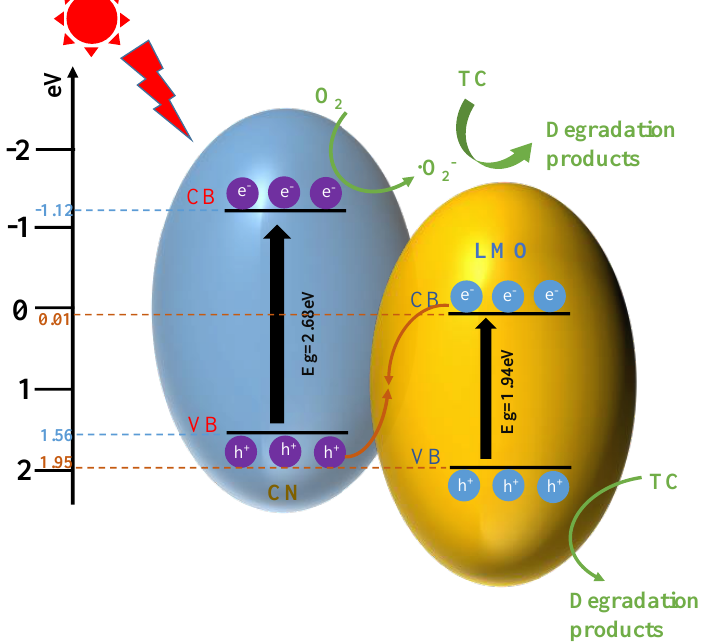
Figure 9. Schematic illustration of the charge separation and transfer process of the LaMnO 3 /g-C 3 N 4 . Excited electrons on LMO combine with electron holes formed on CN, resulting in electron accumulation on CN and hole persistence on LMO. Consequently, the strong reducibility of electrons in CB on CN and the strong oxidation of holes in VB on LMO are maintained. The accumulated electron energy on CB of CN is captured by the dissolved . Considering that the CB potential on CN is lower oxygen in the solution to produce · O − 2 than that of O 2 / · O − , TC can be oxidized and degraded. Concurrently, photogenic holes 2 on LMO can directly oxidize and degrade TC. Therefore, the photocatalytic process is the oxidation reaction between photoholes and superoxide radicals, and the photogenerated carrier is separated in